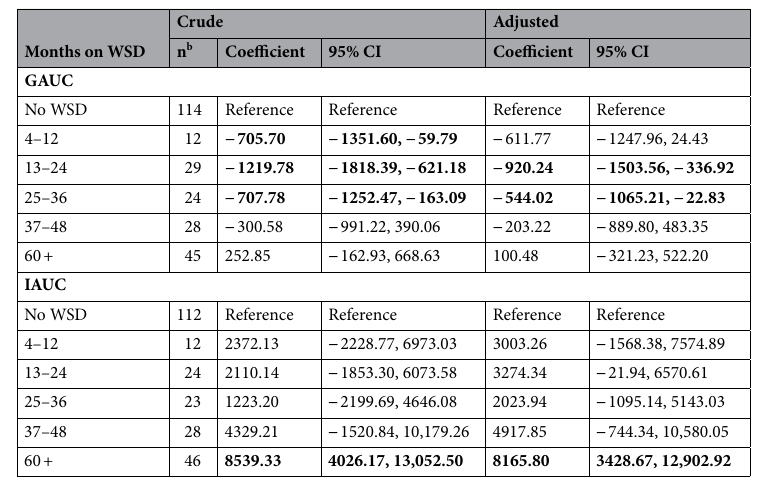
Table 5. Association of months on WSD with third-trimester GAUC and IAUC (n = 254). WSD, western- style diet; CI, confidence interval; GAUC, glucose tolerance test area under the curve; IAUC, insulin area under the curve. a Adjusting for age and parity. b Sample size differs from 254 due to missing GAUC or IAUC measurements. The bold indicates significantly different values from the reference